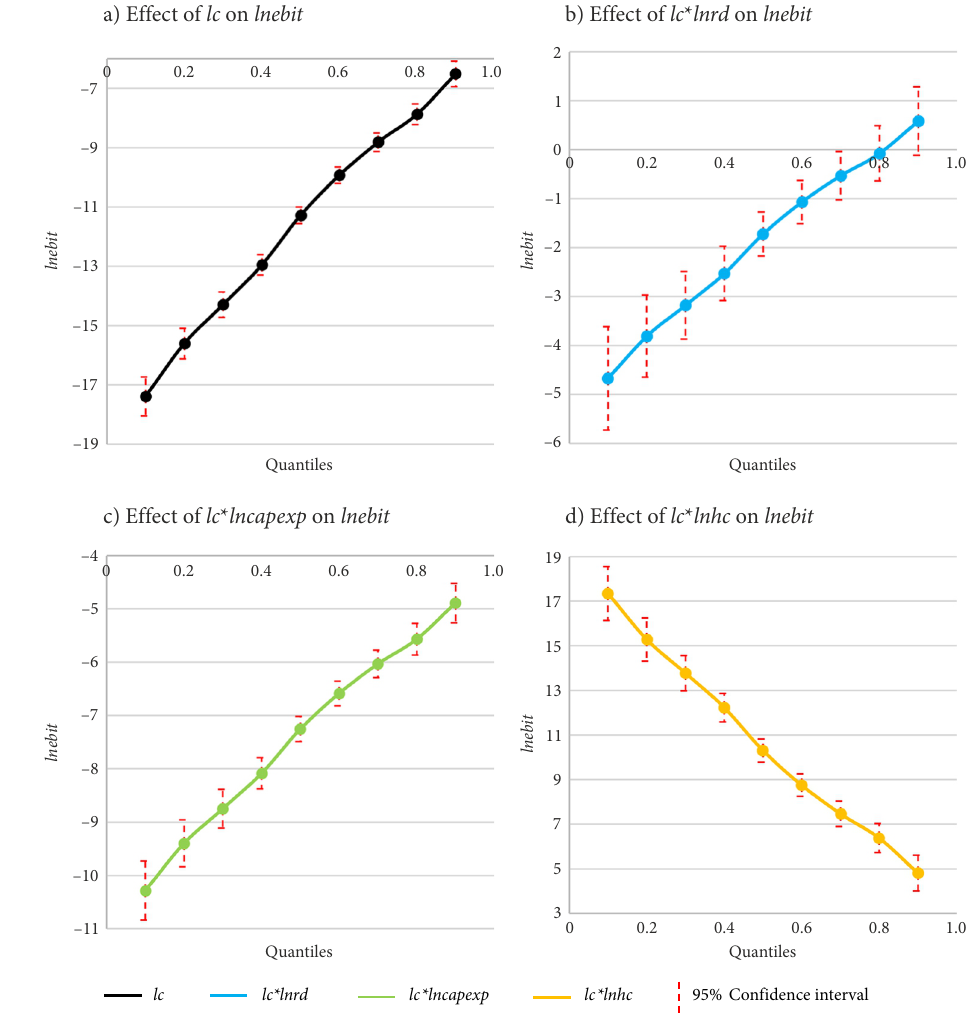
Figure A5. Moderating effect of proportion of human resource training cost on the relationship between three uses of government subsidies and economic